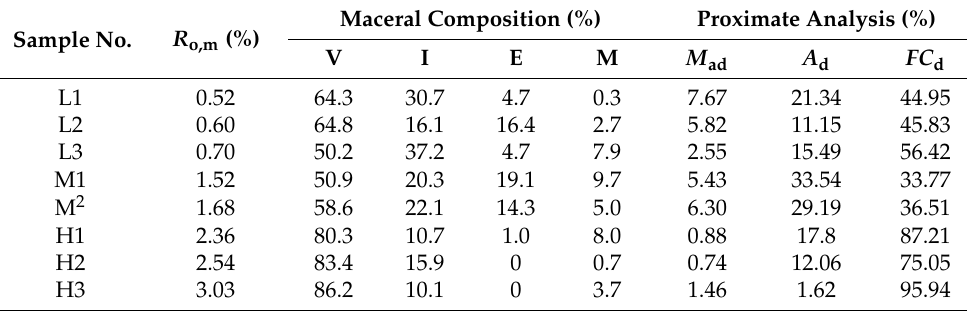
Table 1. Detailed information of the selected coals.